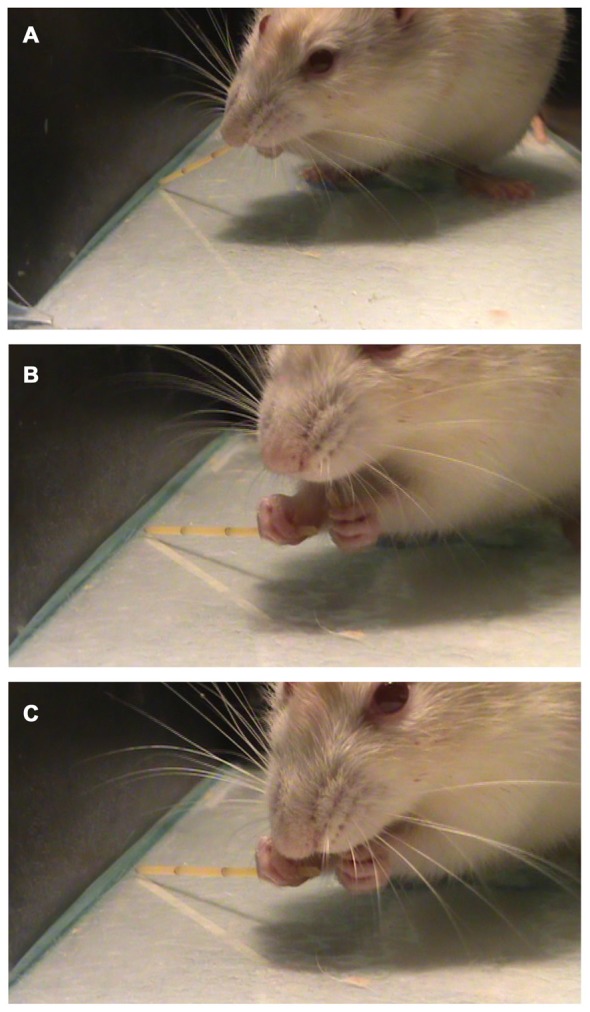
Performing the pasta Test. A representative trial of the pasta test showing a previously unreported behavior called “Break and eat while grasping” in which the animal grasps (A) and breaks the piece of pasta with the mouth (B) and then eats it (C), holding the two pieces of pasta at the same time.